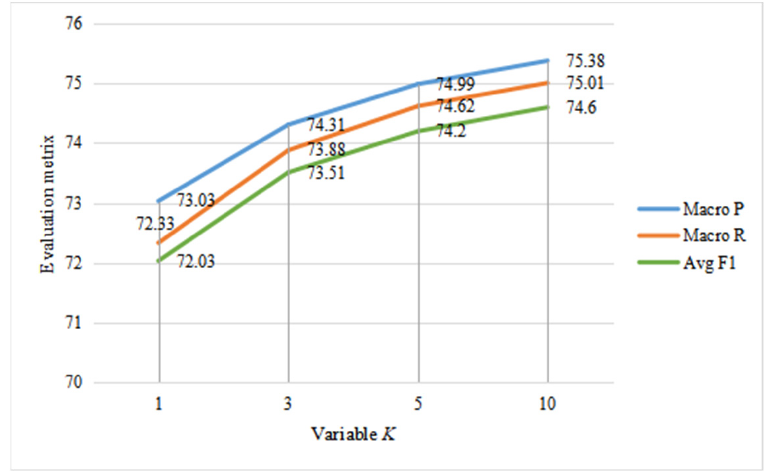
Figure 6. The evaluation of the system with different variable 𝑲 in subsystem 1.